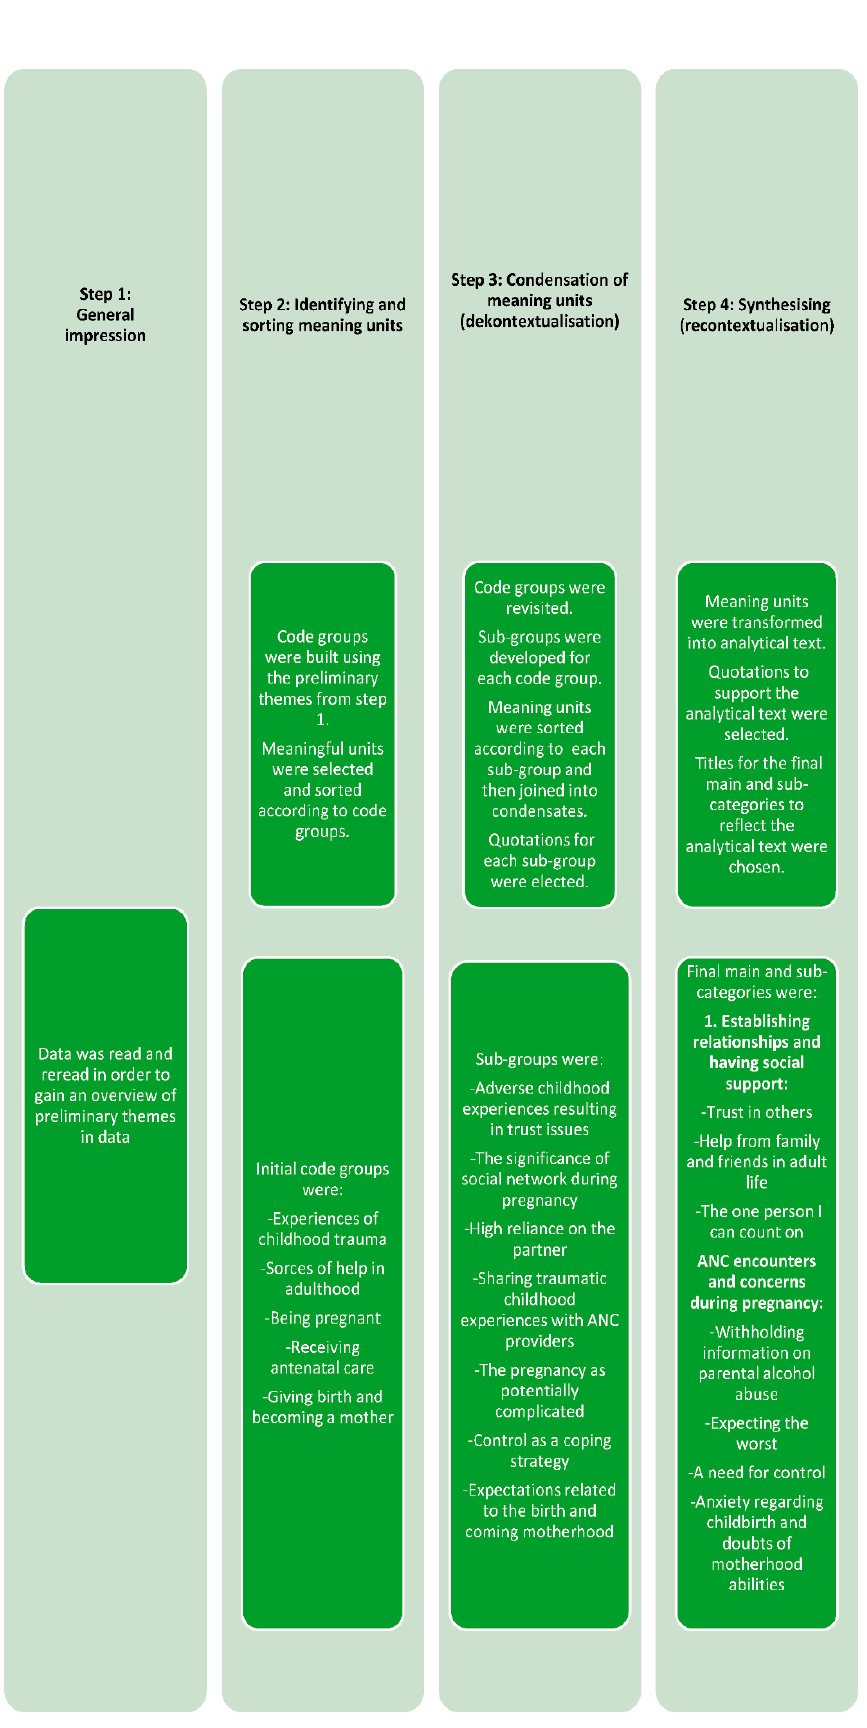
Figure 1. The analysis process.